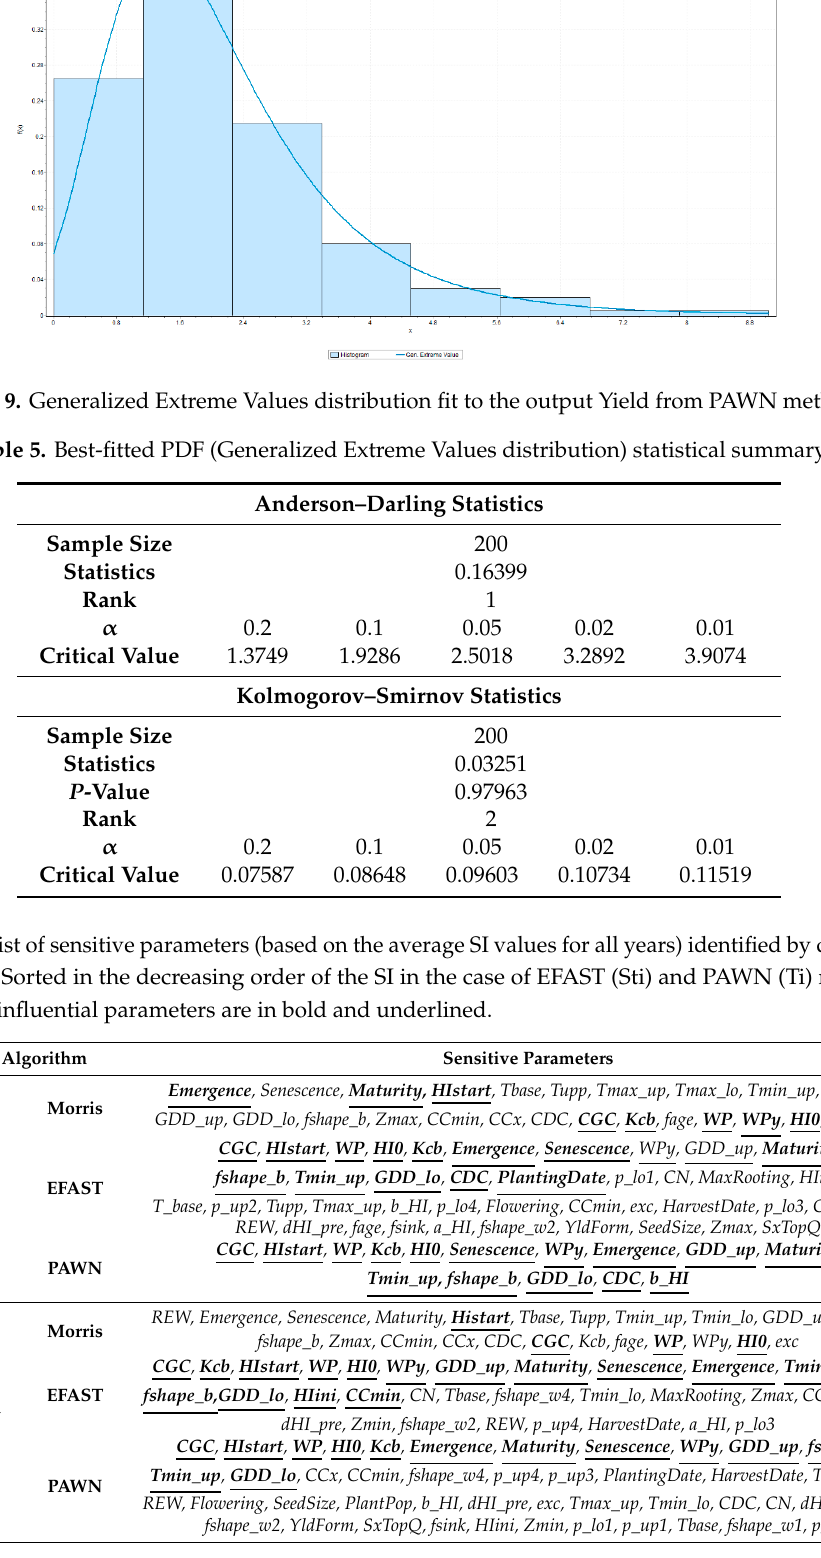
21 of 29 Table 5. Best-fitted PDF (Generalized Extreme Values distribution) statistical summary. Anderson–Darling Statistics Sample Size